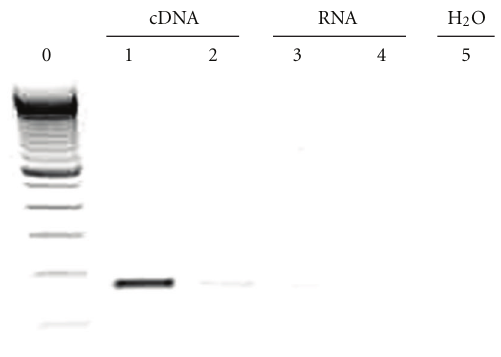
Figure 4: Overexpression of Cxcr4 in bone marrow derived stem cells. The cells at passage 5 were transfected with a mouse Cxcr4 expression vector (pCMV6-Cxcr4) and the stable cell clones expressing Cxcr4 were established. RT-PCR was conducted to examine the mRNA levels of mouse Crcx4 in the transfected or untransfected stem cells at the same passage. Lane 0: 100 bp DNA ladder; lane 1: reverse transcribed sample from the transfected